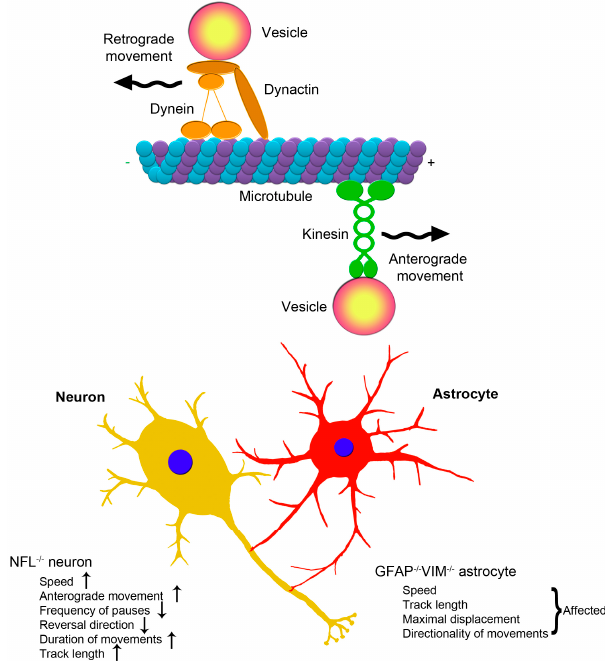
Figure 1. Axonal transport of lysosomes in neurons and astrocytes. Neurons and astrocytes communicate with each other. Both the lack of NFL in neurons and of GFAP and vimentin (VIM) in astrocytes affect lysosome mobility.